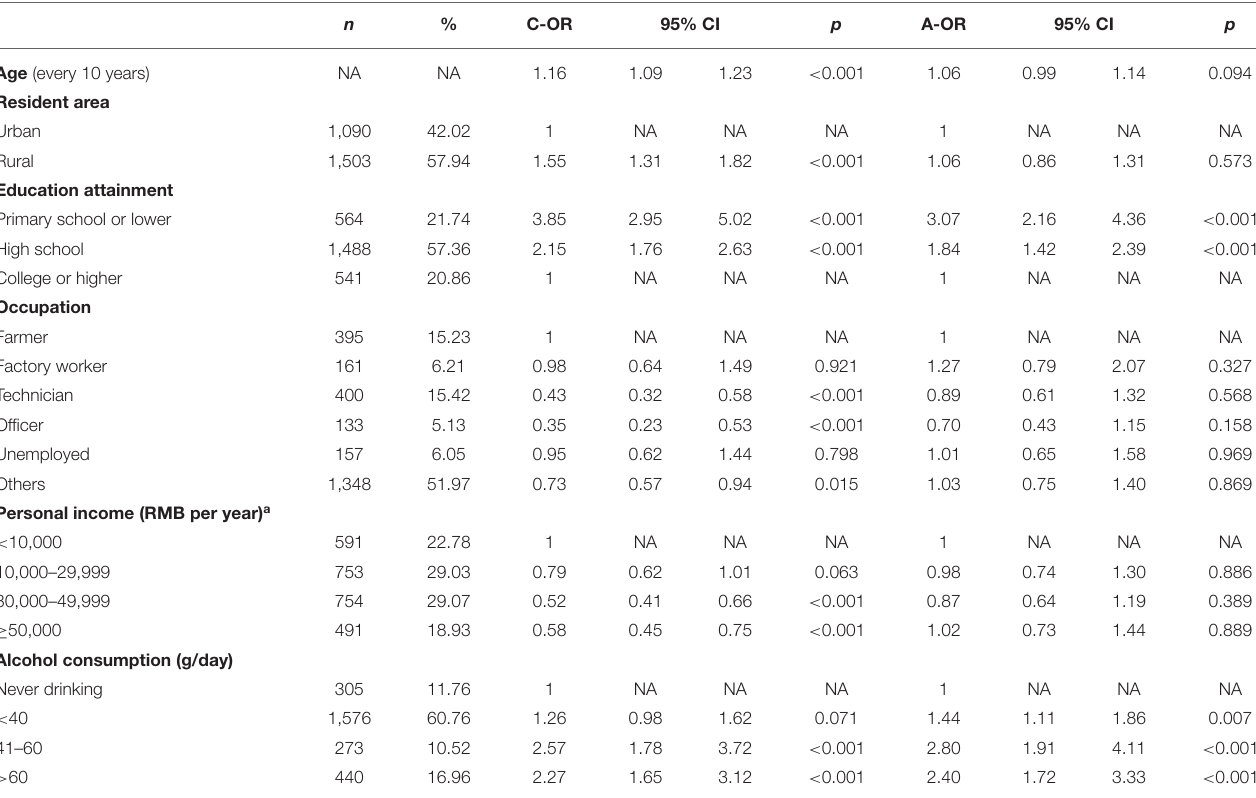
TABLE 3 | The associated factors of ever-smoking in male participants in Hebei Province, central China, 2017. n %